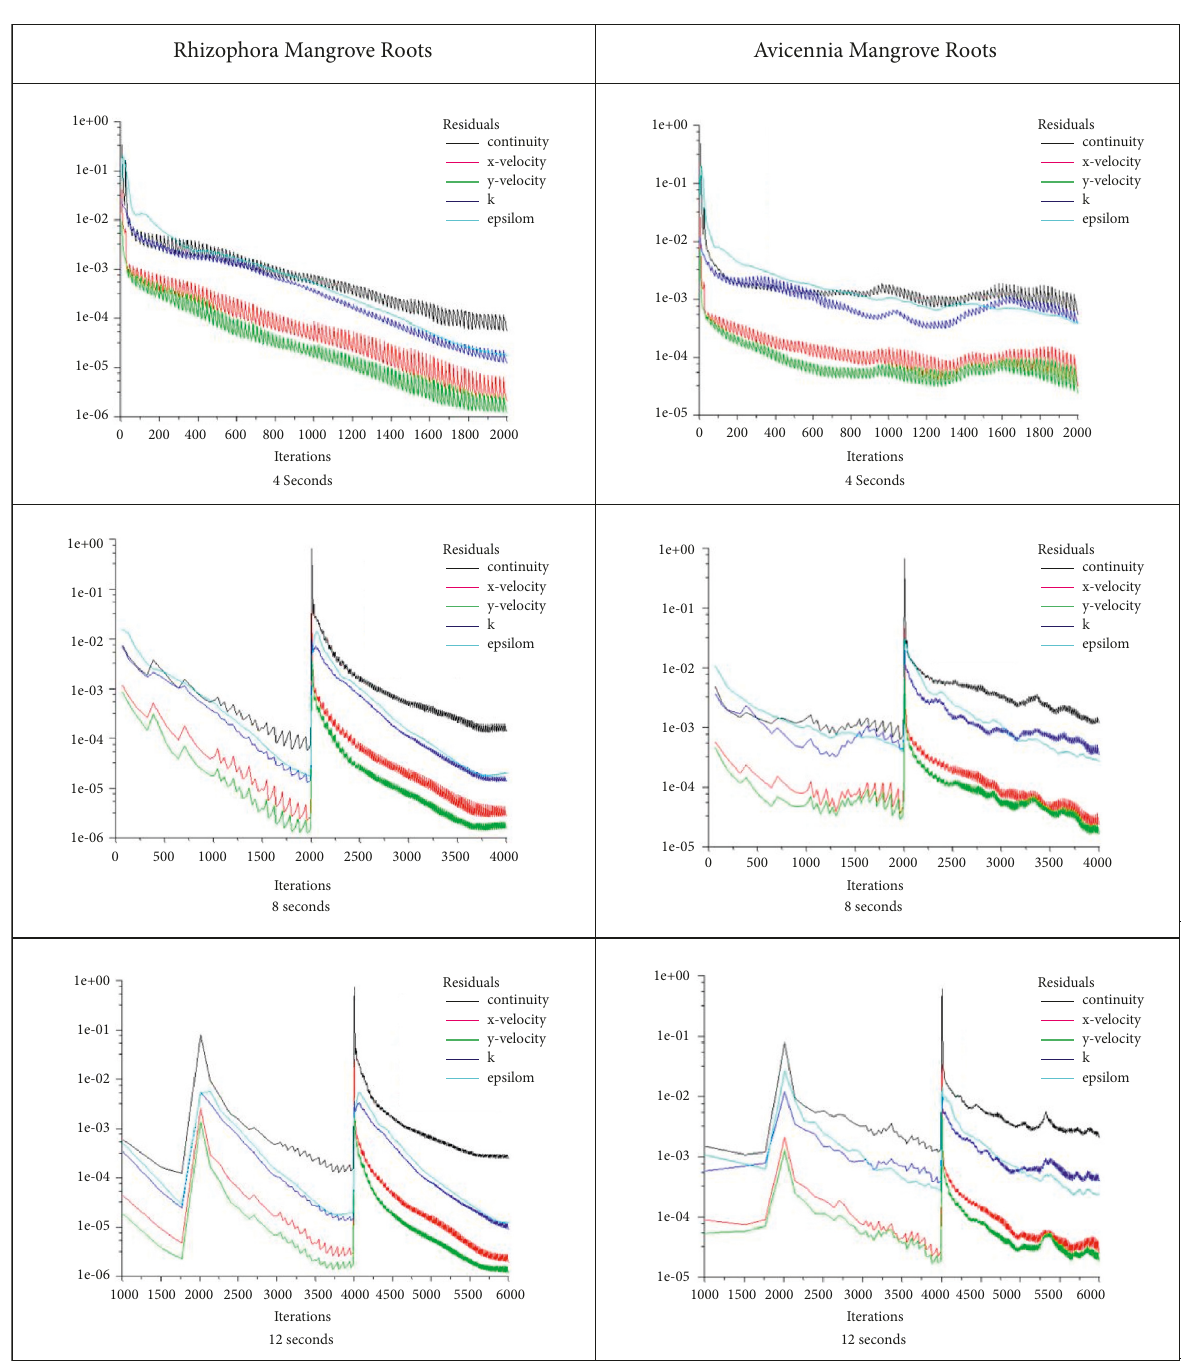
Figure 11: Convergence plot of incompressible unsteady air flow at time intervals of 4 seconds, 8 seconds, and 12 seconds.